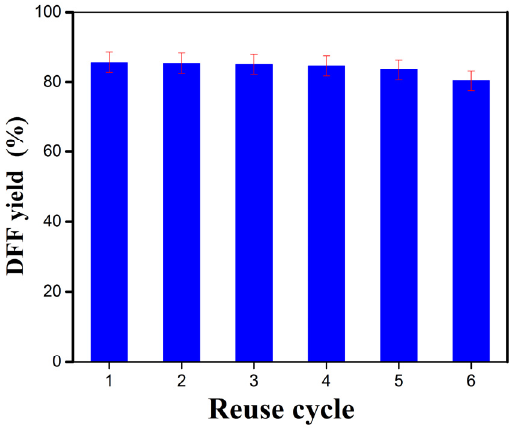
Figure 12. Consecutive use of Cu-K-OMS-2-II for synthesis of DFF.